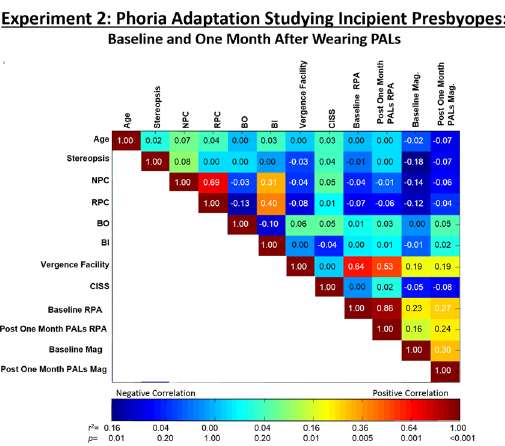
Figure 7. Correlation and statistical significance analysis between all parameters measured during the data collection. Pearson’s correlation coefficient values (r 2 ) are displayed in each bin. The color map shown below correspond to the r 2 and p values. NPC: near point of convergence, RPC: recovery point of convergence, BO: base-out vergence range, BI: base-in vergence range, CISS: convergence insufficiency symptom survey score, RPA: rate of phoria adaptation, Mag: magnitude of change in phoria, Baseline: Before wearing PALs, Post One month after wearing PALs. Positive correlation is denoted in red and negative correlation is denoted in blue. Data are from Experiment 2 studying incipient